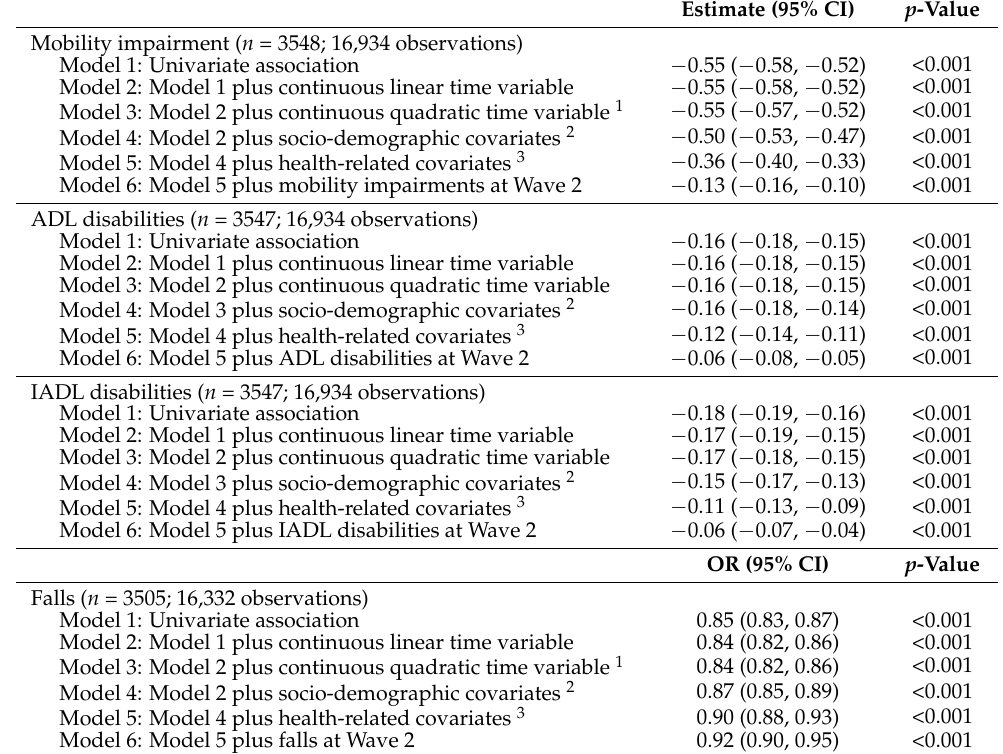
Table 2. Mean changes in mobility impairment, ADL disabilities, IADL disabilities, and the odds ratios of falls per one-point increase in the total SPPB score, using repeated measures outcomes from seven waves of